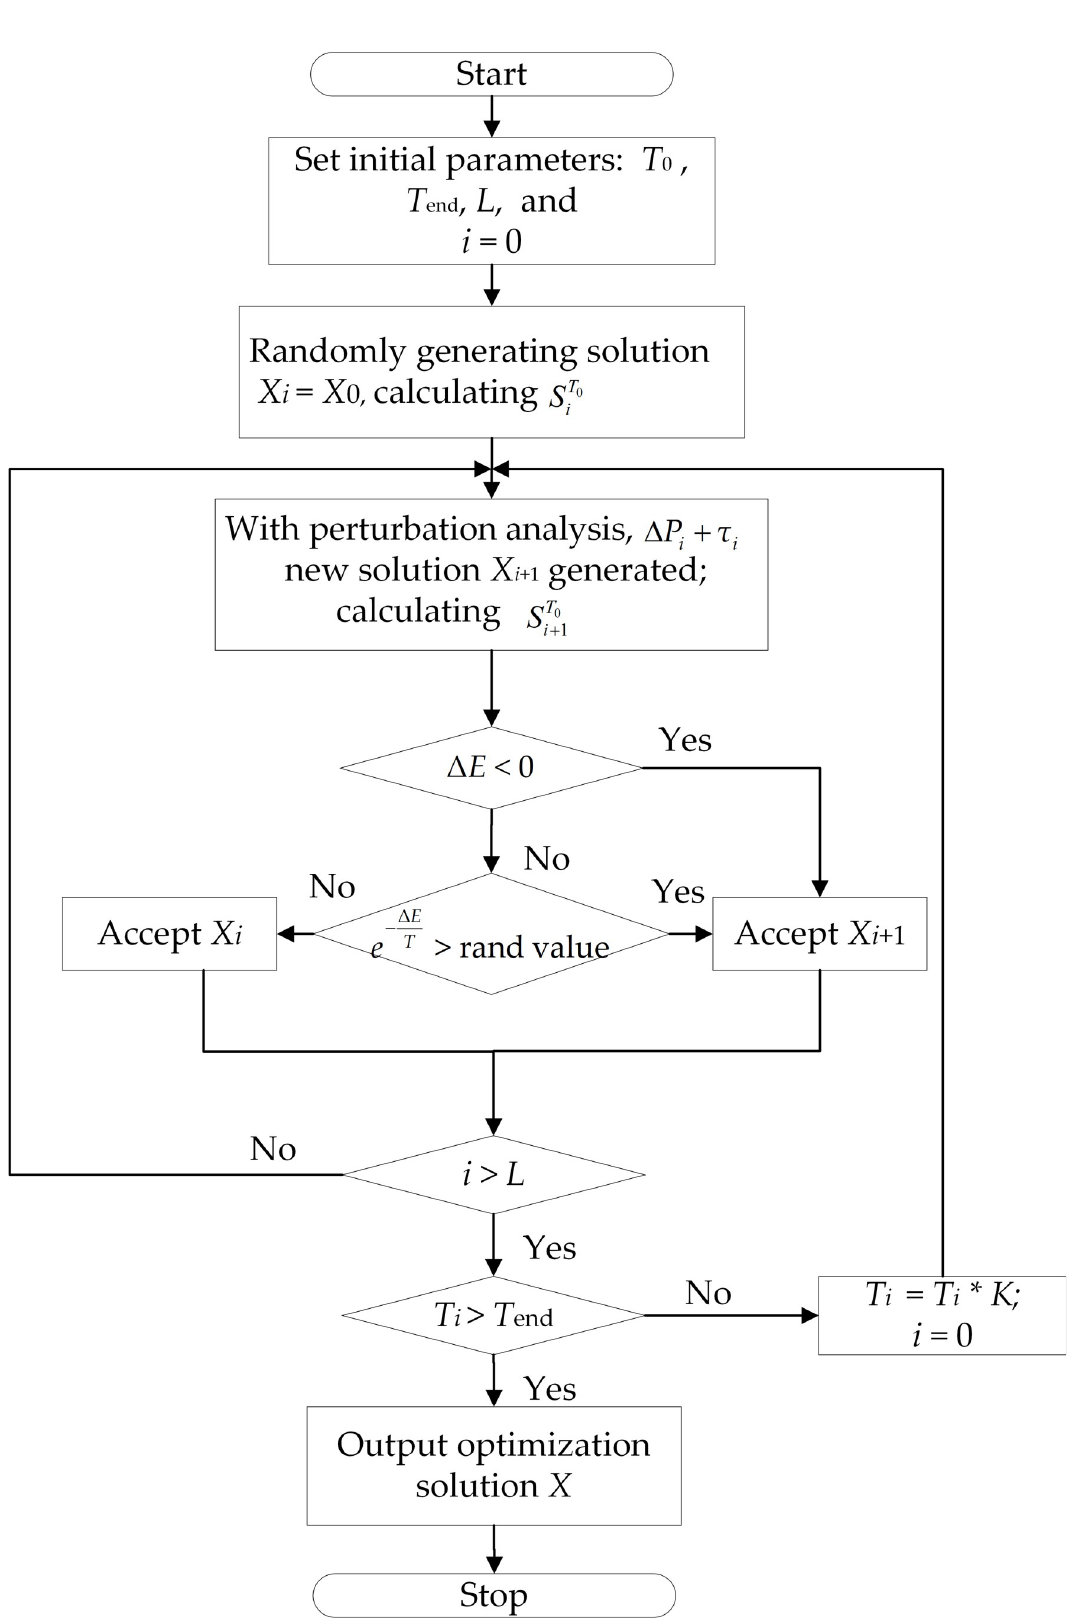
Fig 6. Flowchart of the solution process. https://doi.org/10.1371/journal.pone.0261093.g006 PLOS ONE | https://doi.org/10.1371/journal.pone.0261093 December9,